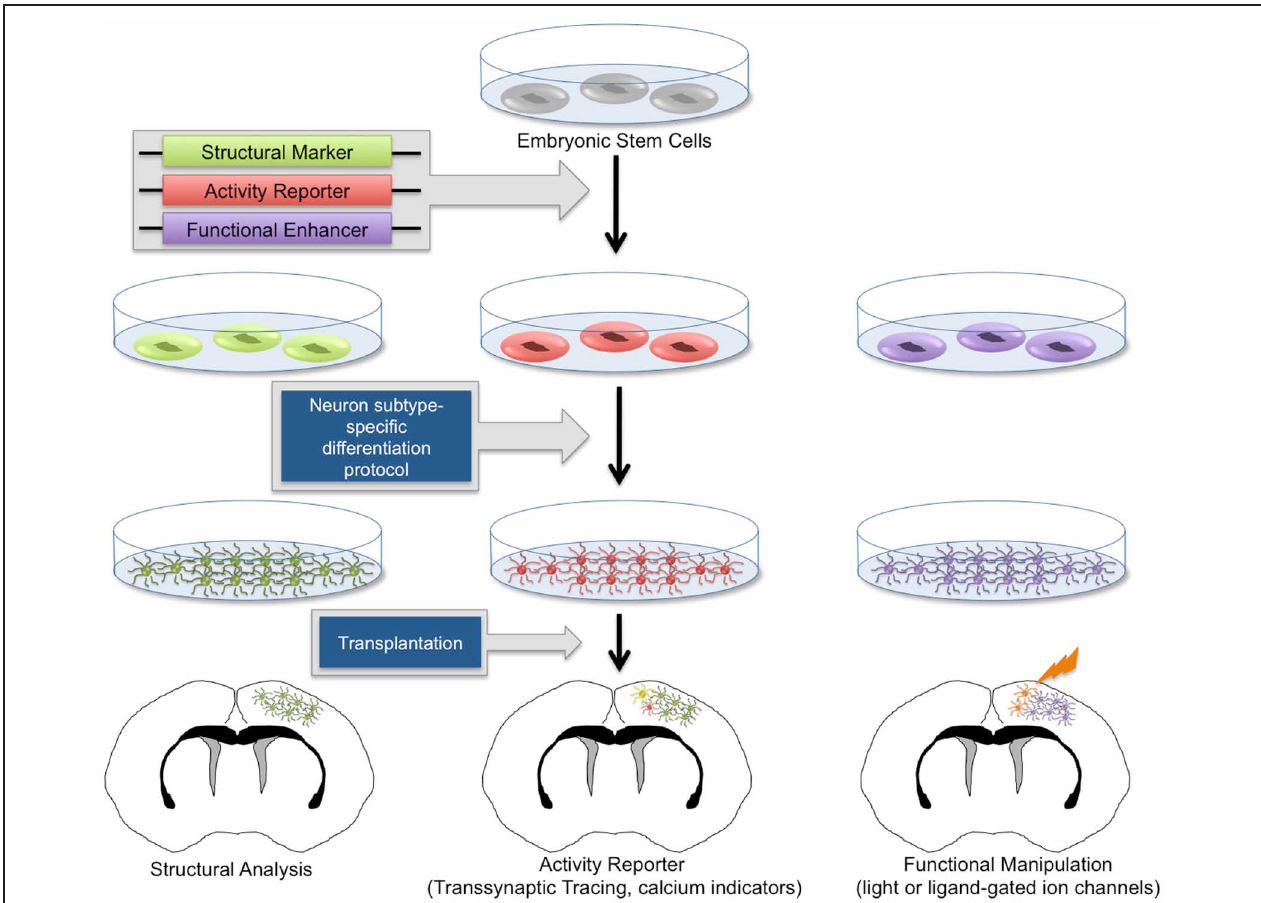
FIGURE 2 | Genetic manipulation of embryonic stem cell-derived neurons. Human and mouse embryonic stem cells (ESCs) can be routinely cultured in vitro . Through genetic manipulations, stem cells can be endowed with structural reporters such as fluorescent markers, activity reporters including transsynaptic tracing machinery and calcium indicators, as well as functional enhancers such as light-responsive proteins and exogenous ligand-activated ion channels. Upon neuron